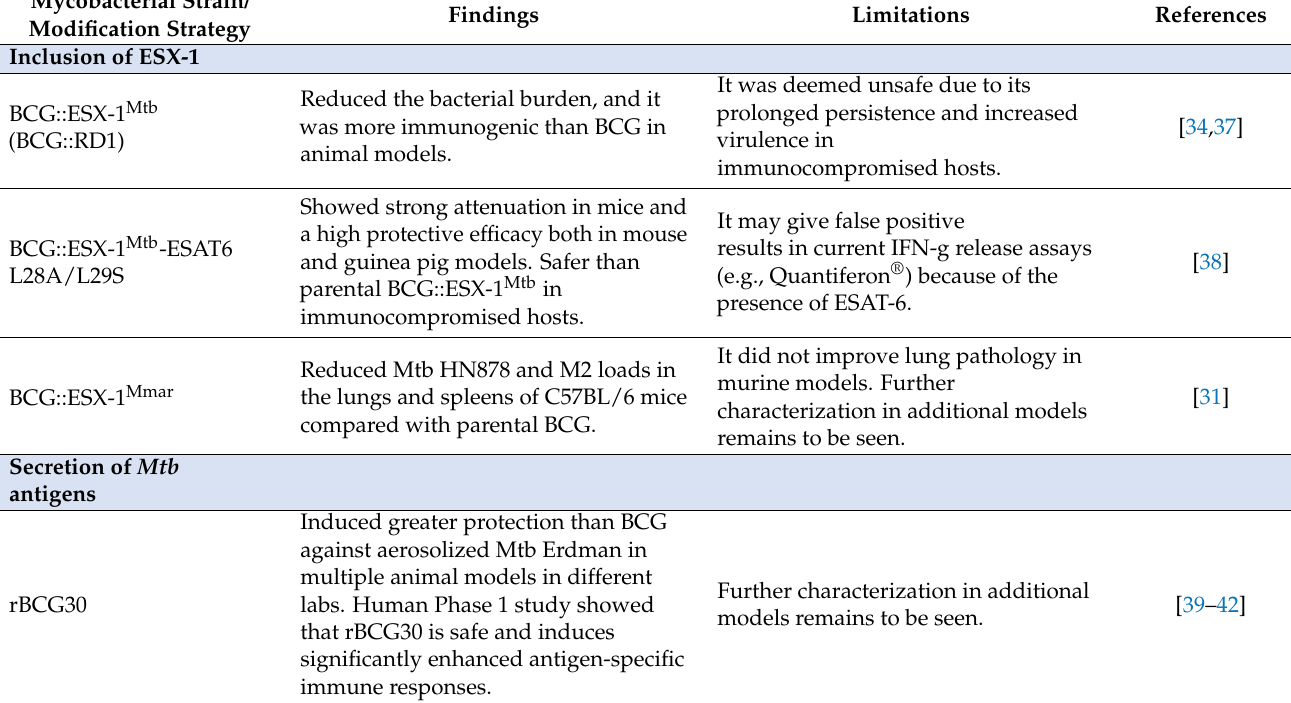
Table 1. Summary of various mycobacteria-based vaccine candidates and their properties. Mycobacterial Strain/ Modification Strategy